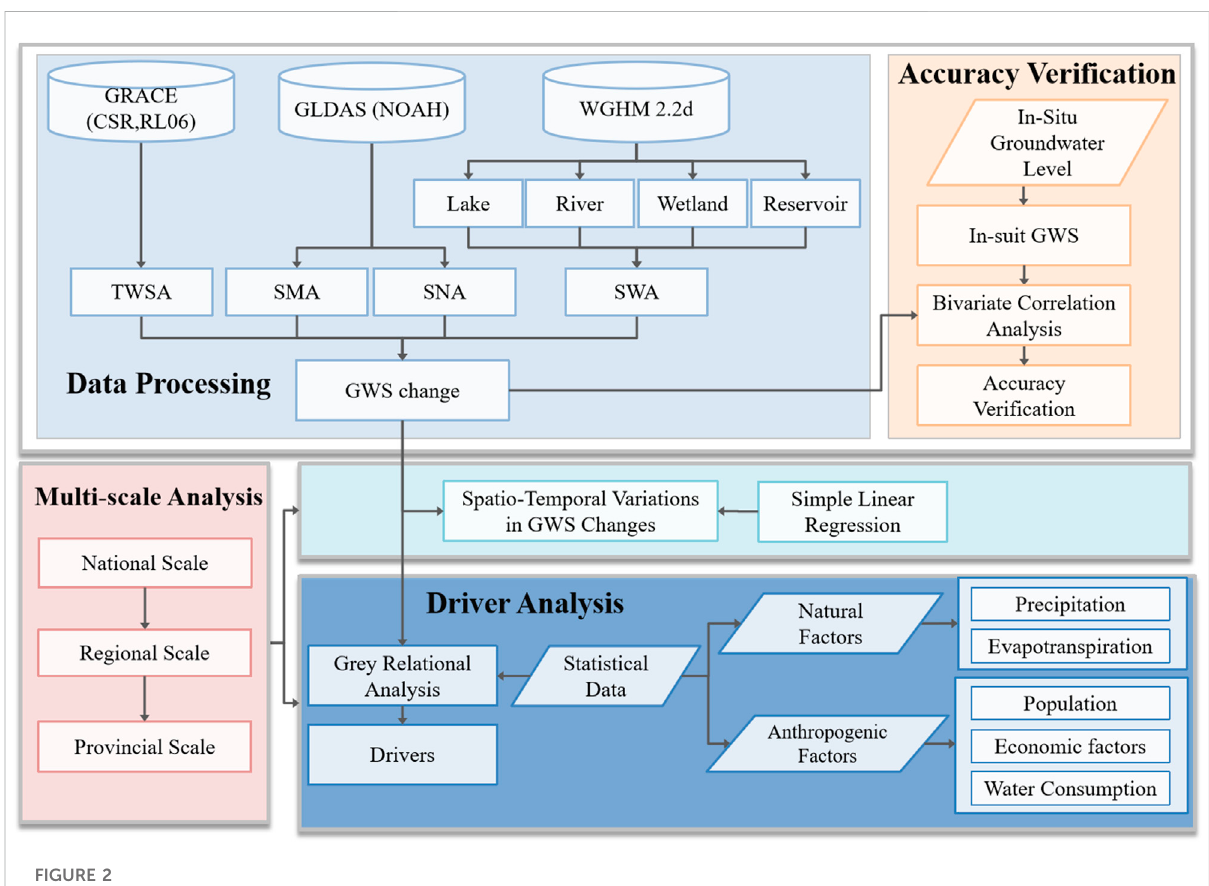
FIGURE 2 Framework for investigating GWS change and driving